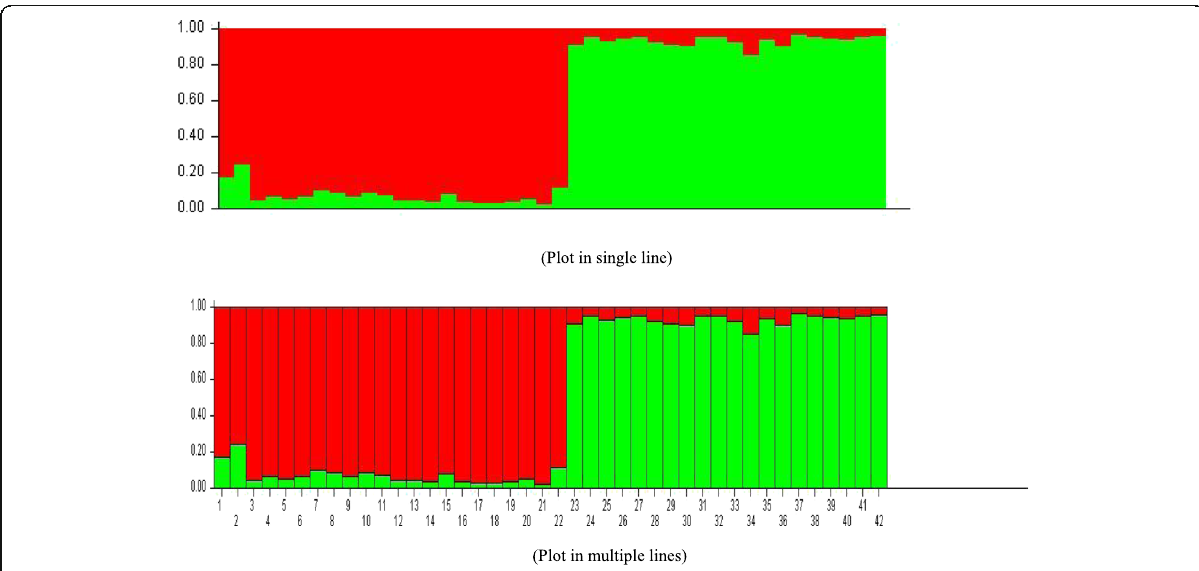
Fig. 2 Bar plot from structure results using K = 2 clusters. Group 1 = 1 – 22 samples Jumbo (WJQS) and Group 2 = 23 – 42 samples gray (GJQS) Japanese quail strains; each vertical line represents the proportion of origin (q) of an individual in the first (green, GJQS) and second (red, WJQS)